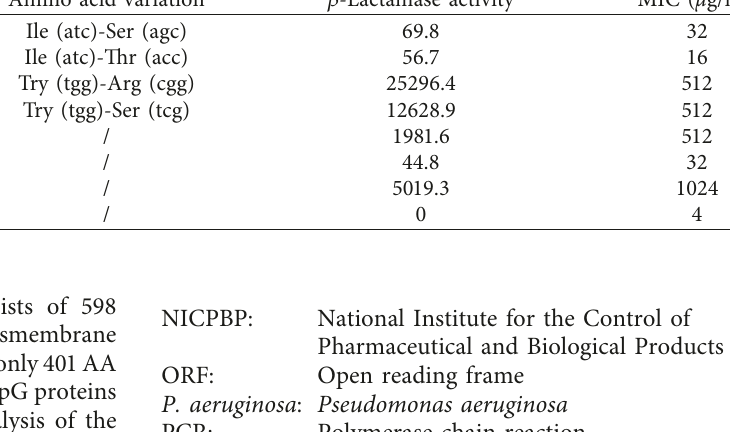
Table 4: MIC levels to ampicillin and AmpC β -lactamase activity of the site-directed mutants. Strain Amino acid